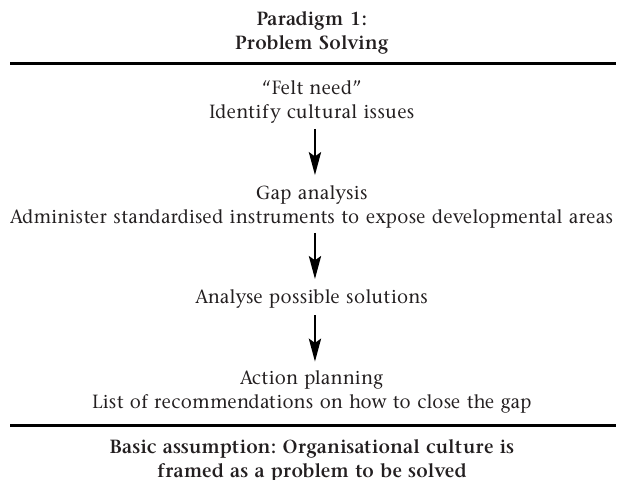
Figure 1: Problem solving paradigm (derived from Coopperrider & Whitney, 200,